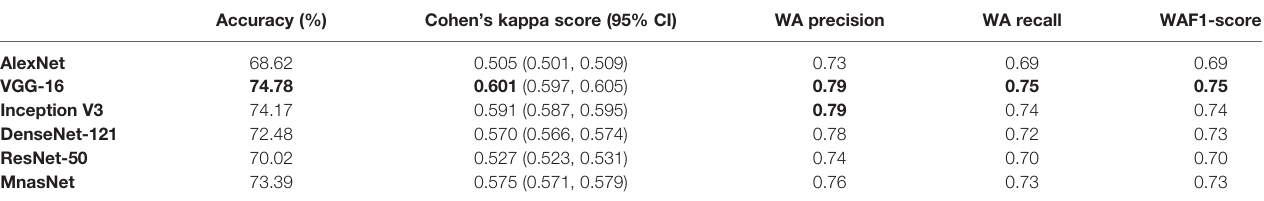
TABLE 2 | Performance of patch-level ternary classi fi cation on testing dataset.